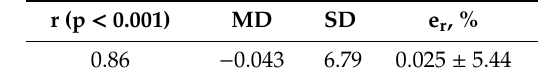
Table 2. Evaluation of the performance of the systolic blood pressure estimation methods (MD— mean difference, SD—standard deviation, SPS—samples per second).